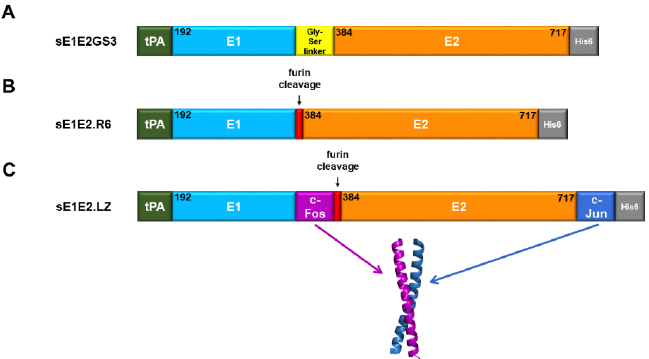
Figure 11. Design of selected sE1E2 constructs. ( A ). Schematic of sE1E2GS3. ( B ). Schematic of sE1E2.R6. ( C ). Schematic of sE1E2.LZ and the X-ray structure of the human c-Fos/c-Jun heterodimer (PDB code: 1FOS); only the coiled-coil region that was used for the sE1E2.LZ scaffold is shown. c-Fos and c-Jun chains were colored to match the diagram of sE1E2.LZ. Regions shown include the tPA signal sequence (green), E1 ectodomain (cyan), E2 ectodomain (orange), Gly-Ser linker (yellow), and c-Fos and c-Jun scaffolds (magenta and blue). Location of the His tag (gray) and furin cleavage site (red) is indicated where applicable. E1E2 residue ranges for each region are noted according to H77 numbering. Table 2. Binding affinity of mbE1E2, sE1E2.LZ, and sE2 to a panel of monoclonal antibodies measured by dose- dependent ELISA.